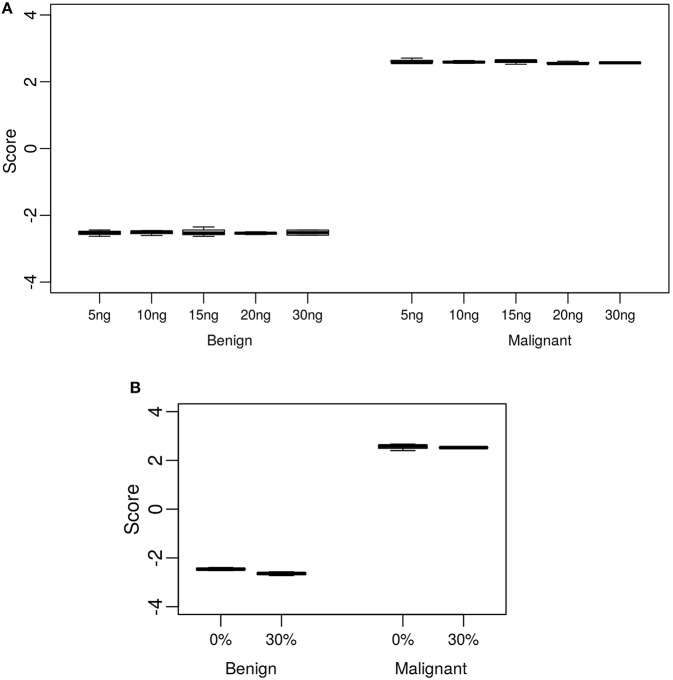
Analytical sensitivity and specificity of the Afirma GSC BM classifier. The y-axis spans the observed score range of the classifier being tested. (A) Effect of input mass variation on Afirma GSC scores. Each box represents classifier scores of technical triplicates for either one benign sample or malignant sample. The x-axis shows the total input mass. Overall, GSC scores for each sample did not differ significantly with RNA input amount (p-value = 0.97). (B) Analytical specificity of the Afirma GSC BM classifier against genomic DNA (gDNA). The x-axis shows the percentage of gDNA spiked into 15 ng of total RNA samples before library preparation. Each box represents classifier scores of all technical replicates for either one benign or malignant sample. Overall, the Afirma GSC BM classifier scores of the same samples with 30% gDNA spike-in are not significantly different from the scores of the corresponding pure RNA samples (p-value = 0.064).